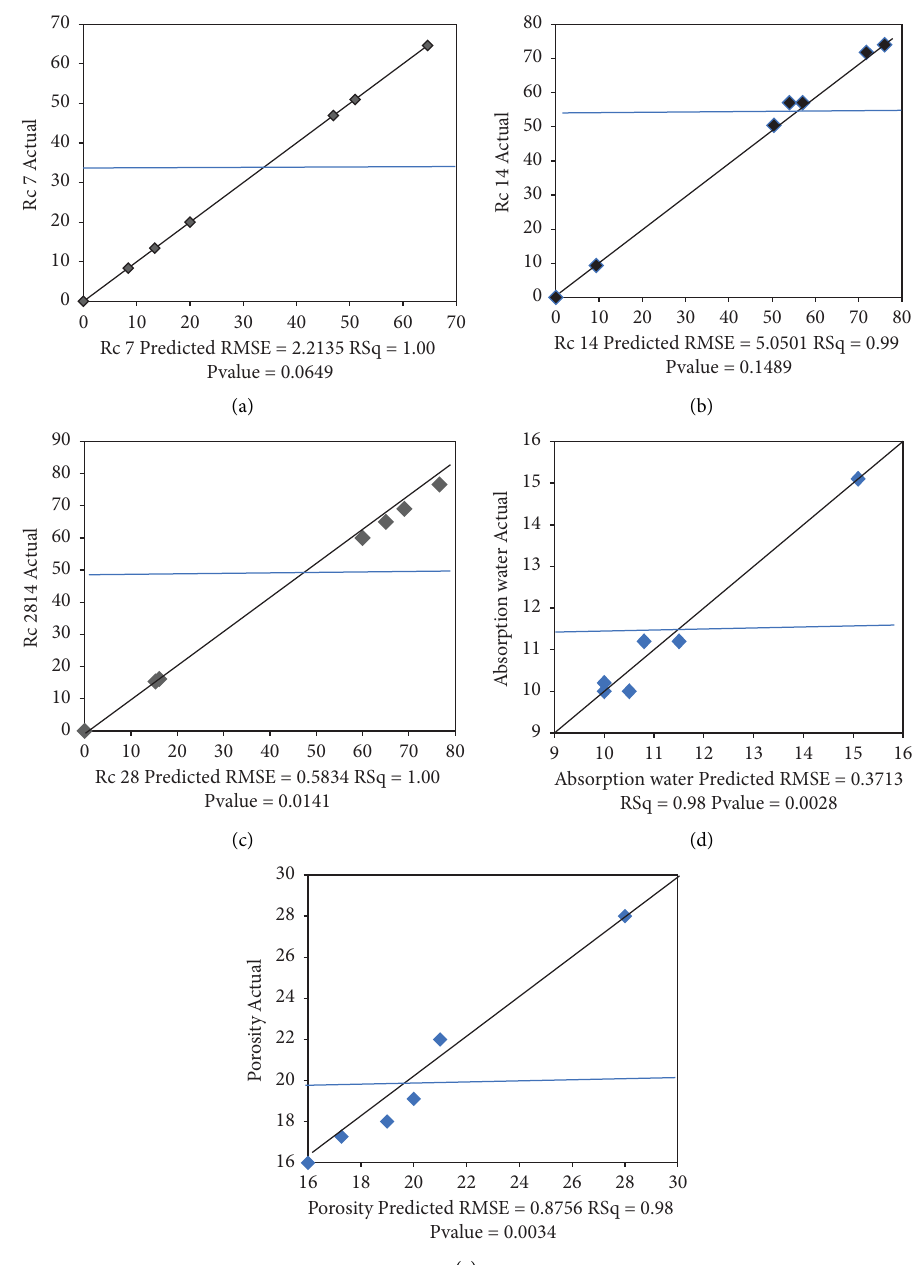
Figure 5: Correlation between the observed and predicted responses (RC7 (a), RC14 (b), RC28 (c), water absorption (d), and porosity (e)) at 28